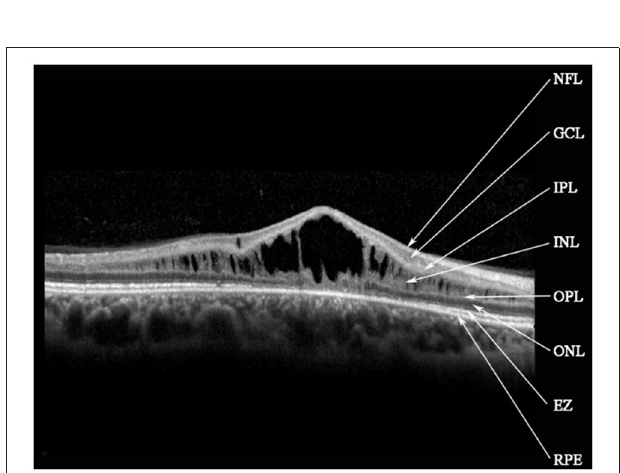
FIGURE 3 | Spectral-domain optical coherence tomography image reveals macular schisis cavities in inner nuclear layer (INL), outer plexiform layer (OPL), and outer nuclear layer (ONL). Small cystic cavities were found in the ganglion cell layer (GCL). NFL, nerve fiber layer; IPL, inner plexiform layer; EZ, ellipsoid zone; RPE, retinal pigment epithelium.